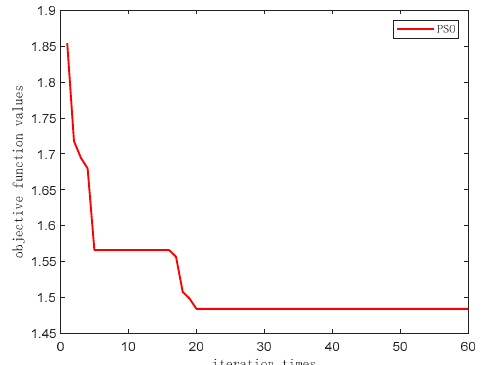
Appl. Sci. 2020 , 10 , x FOR PEER REVIEW Figure 7. Iterative process diagrams of PSO. Figure 7. Iterative process diagrams of PSO.